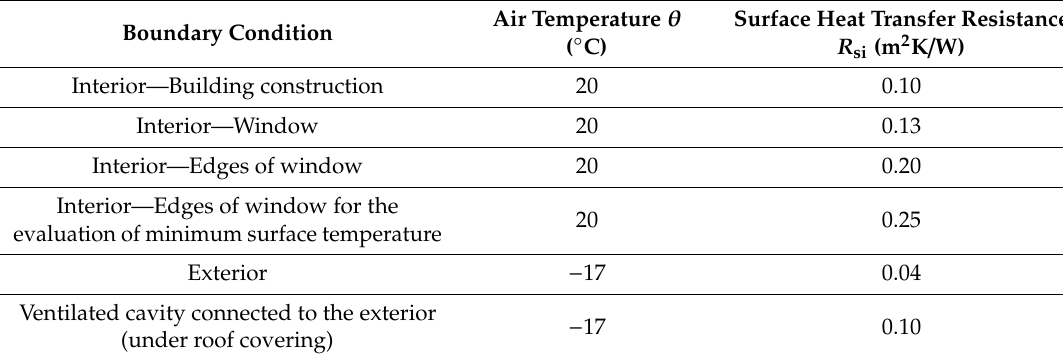
Table 4. Boundary conditions and heat flux scale used in the 2D heat transfer calculations.